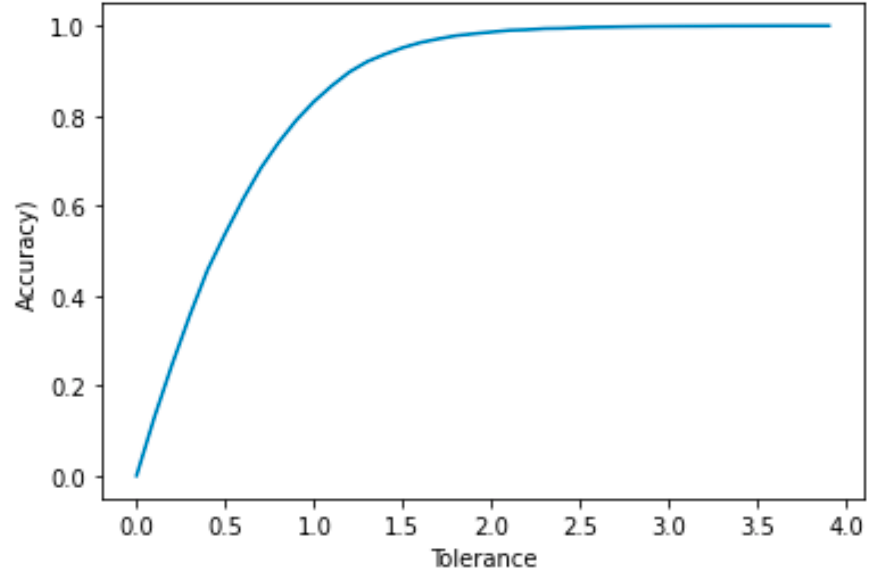
Figure 5. Number of images with errors according to the absolute error in predicted ages.